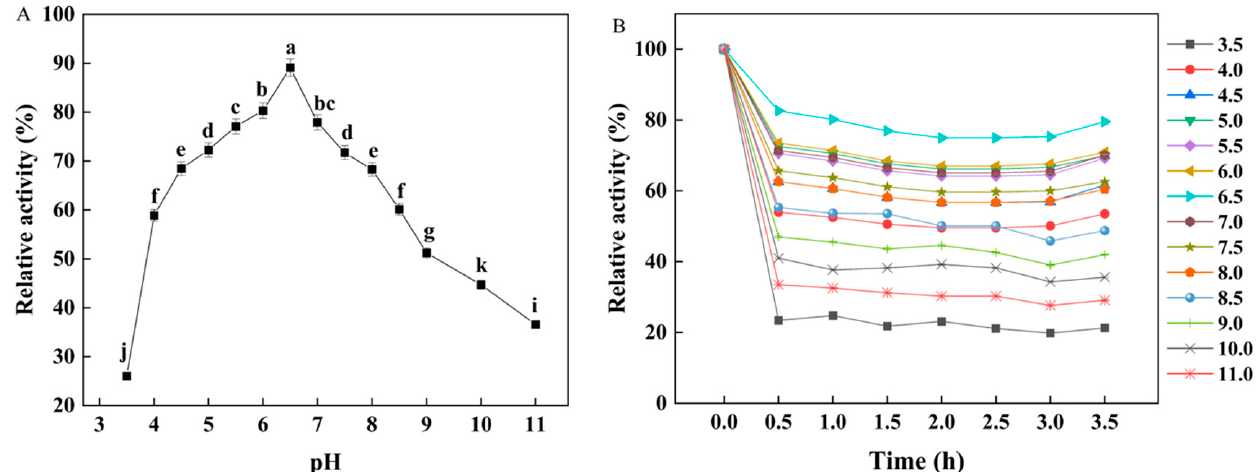
Figure 3. Effects of pH value ( A ) and pH value stability ( B ) on the enzyme activity of W. cibaria F1. Different letters in superscript donate significant difference ( p < 0.05).